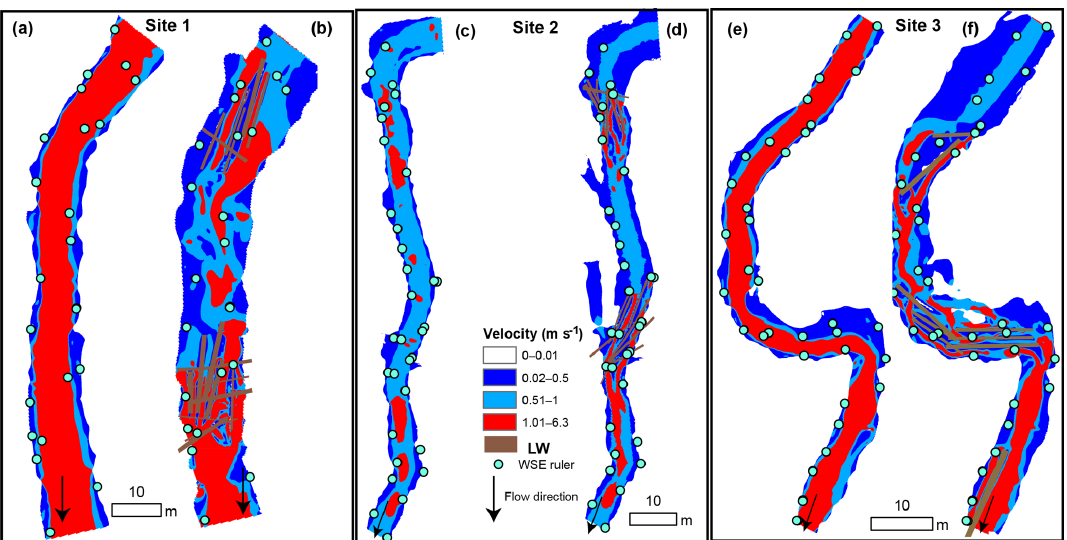
Figure 3. Mean flow velocity at bankfull discharge before (a, c, e) and after (b, d, f) the addition of large wood (LW) in Sites 1, 2, and 3. The colors correspond to thresholds of velocity relevant to the ability of juvenile coho salmon to maintain position in the stream: dark blue means v<v crit where v crit = 0 . 5ms − 1 , light blue means v crit <v<v burst where v burst = 1ms − 1 , and red means v>v burst . The location of the installed water surface rulers is included to facilitate visual comparison of the increased extent of floodplain inundation in each site during bankfull